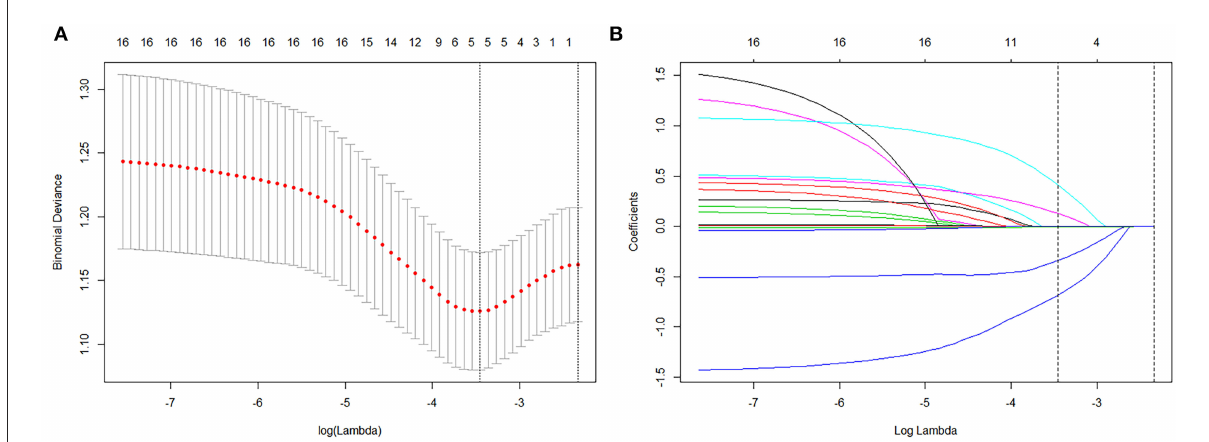
FIGURE2 Texture feature selection using the least absolute shrinkage and selection operator (LASSO) method. (A) Tuning parameter ( λ ) selection in the LASSO model used 10-fold cross-validation via minimum criteria. The binomial deviance was plotted vs. log (Lambda). Dotted vertical lines were drawn at the optimal values by using the minimum criteria and the 1 standard error of the minimum criteria (the 1-SE criteria). Log (Lambda) − 3.809 was chosen (1-SE criteria) according to 10-fold cross-validation. (B) LASSO coefficient profiles of the 15 texture features. A coefficient profile plot was produced against the log ( λ ) sequence. Vertical line was drawn at the value selected using a 10-fold cross-validation, where optimal λ resulted in 5 nonzero coefficients.